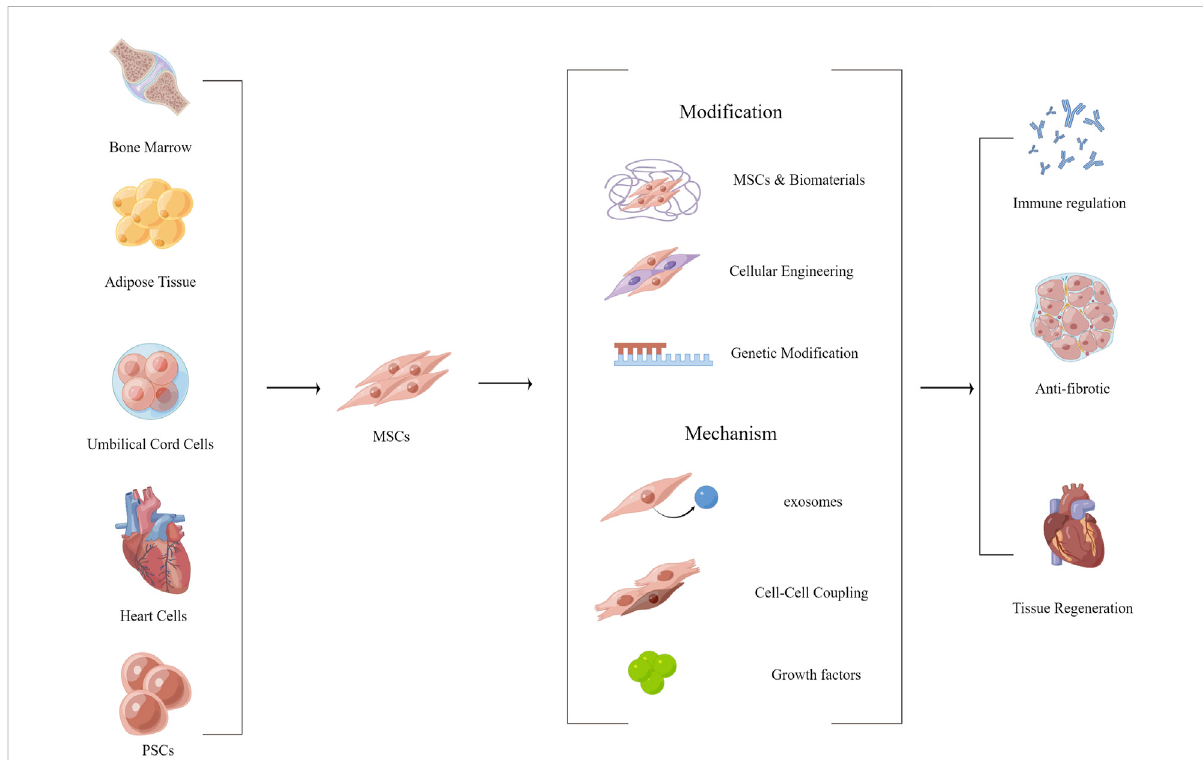
FIGURE 3 Functionalized modi fi cation of MSCs, effect and mechanism of MSCs on myocardial fi brosis. (By